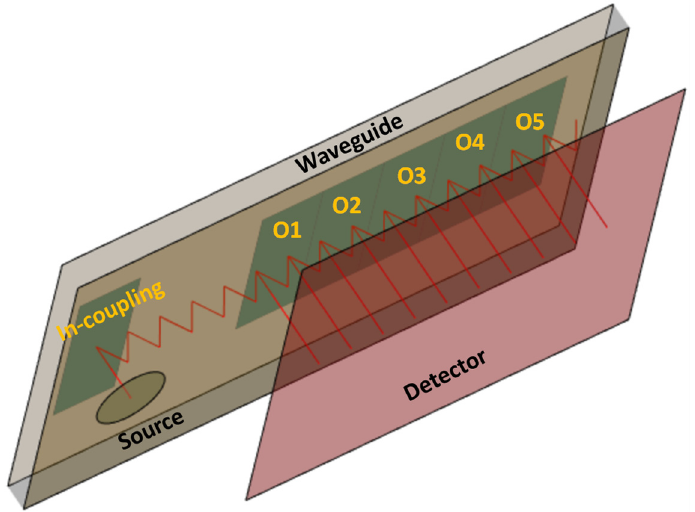
Figure 8. Location of duplicated exit pupils obtained by tracing the rays of central field. The entrance pupil is circular and 4 mm across.